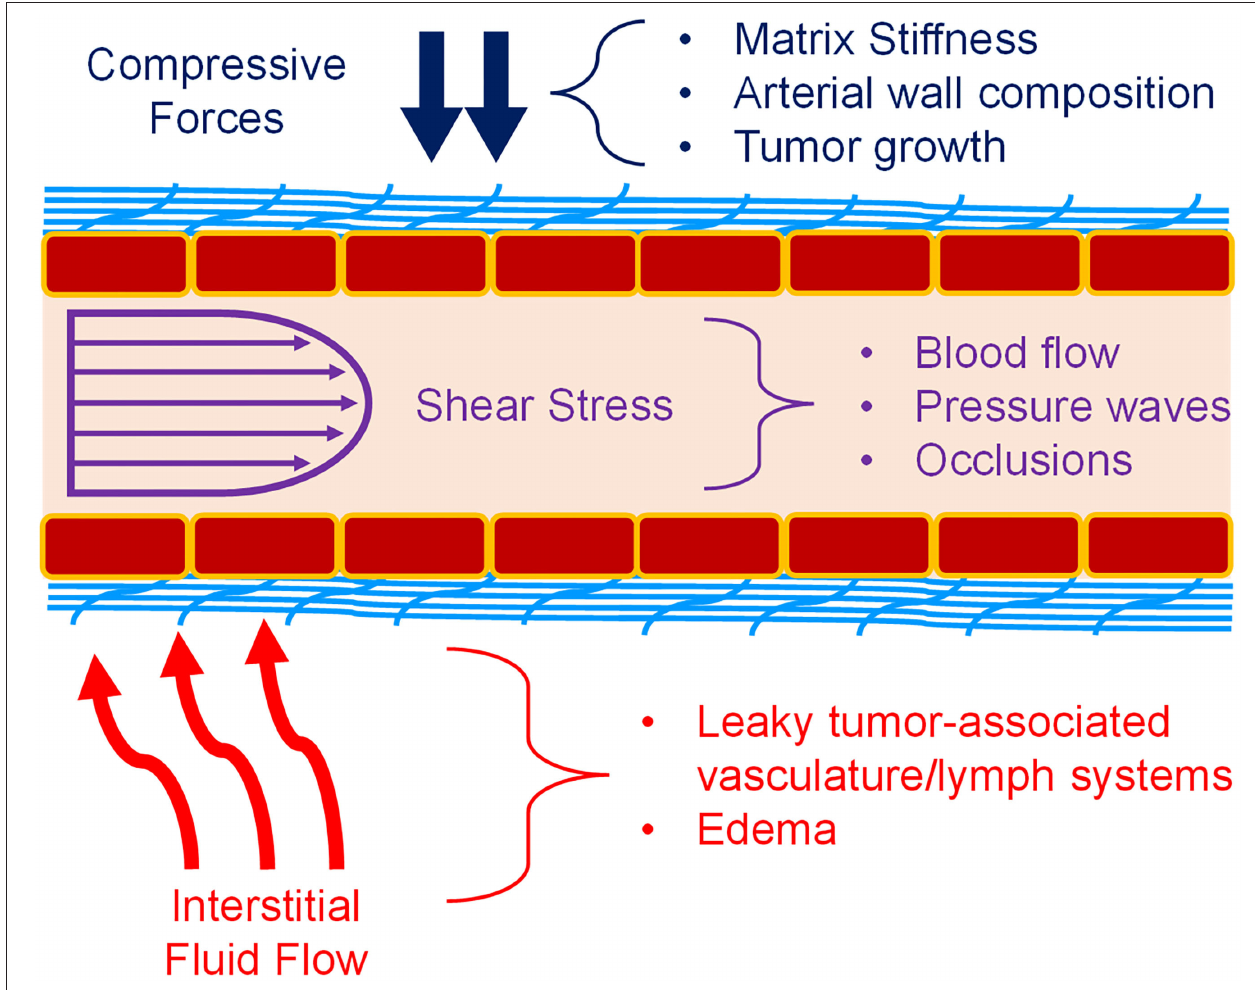
FIGURE 1 | Mechanical forces in blood vessels. Vascular ECs (red boxes) experience a variety of forces. Compressive forces (blue) can be caused by matrix (light blue) stiffness, tumor expansion, and surrounding cells. Shear stress (purple) caused by blood flow is also a major component of the vascular environment. Pulsatile flow and atherosclerosis also affect fluid flow and the resulting shear stress. Interstitial fluid flow and pressure (red) is also present during angiogenesis, and especially in the TME. Permeable vasculature is commonly present in disease states such as tumors and edema. Figure was derived based on the following references: